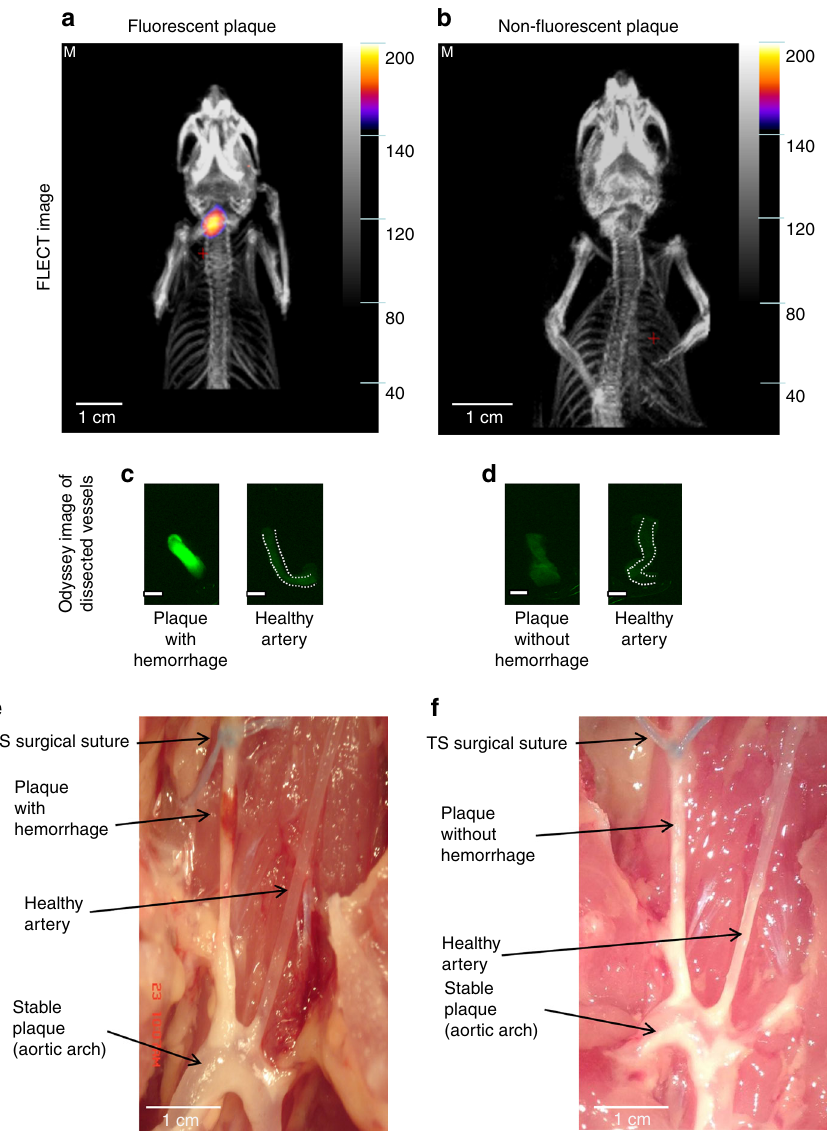
Fig. 8 Fluorescence emission computed tomography (FLECT) and anatomical images of mice following TS ligation. a FLECT image of a mouse with unstable carotid artery plaque (segment I) and intraplaque hemorrhage. CT image reconstruction showed NIRAF originating from the carotid artery (segment I). b FLECT image of another mouse that did not develop intraplaque hemorrhage in segment I (only ~50% of mice develop intraplaque hemorrhage after TS surgery 16 ) and did not exhibit signi fi cant NIRAF. c The dissected unstable plaque of the right carotid artery ( left ) was scanned together with the healthy left carotid vessel ( right ) using the Odyssey Infrared Imaging System. NIRAF signal was seen in the unstable plaque with hemorrhage. d The dissected plaque without intraplaque hemorrhage and its contralateral heathy carotid vessel were also collected and scanned. No NIRAF was detected in these vessels. e Anatomical depiction of a TS mouse with macroscopically visible hemorrhage. f Anatomical depiction of a TS mouse without hemorrhage (suture appears blue ). Note: a , c , e were from a TS mouse with hemorrhagic phenotype. b , d , f were from a TS mouse with non-hemorrhagic phenotype. Experiments were performed 10 times and one representative example is shown. Scale bars indicate 1 mm in c and